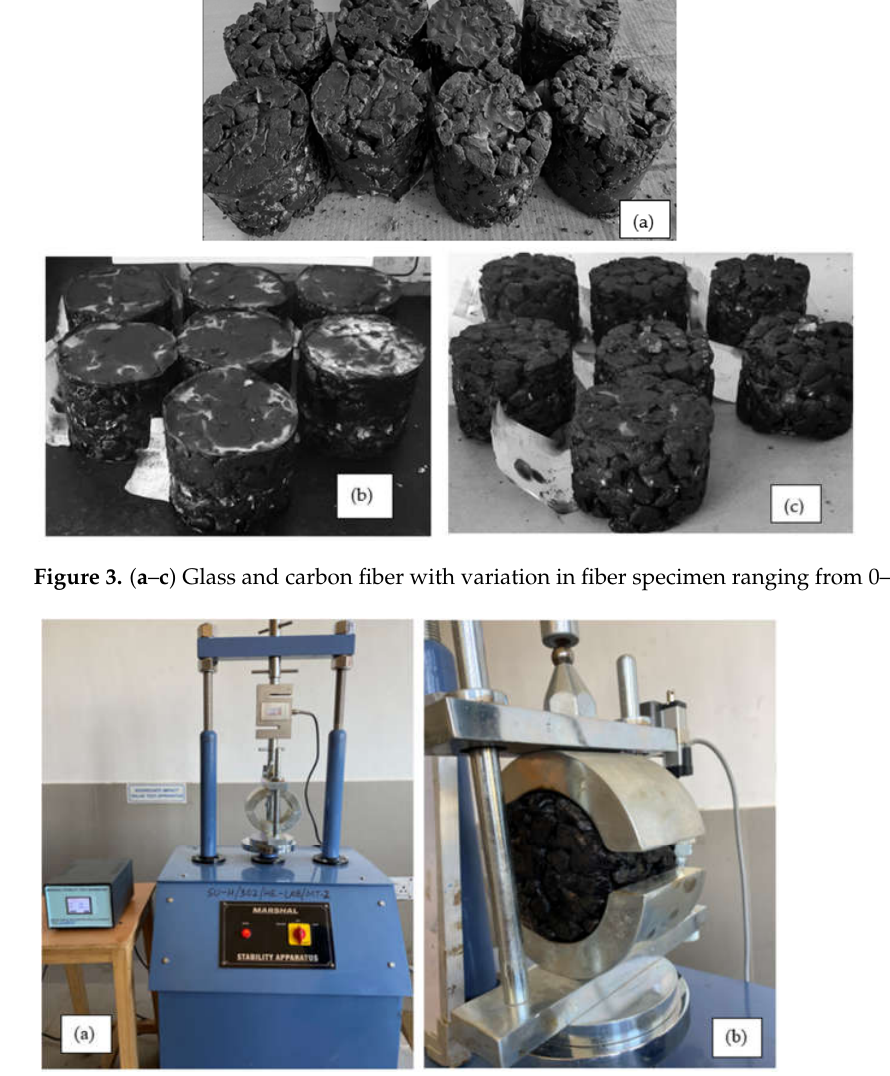
Figure 4. ( a , b ) Marshall stability testing apparatus and testing of the Marshall specimen.